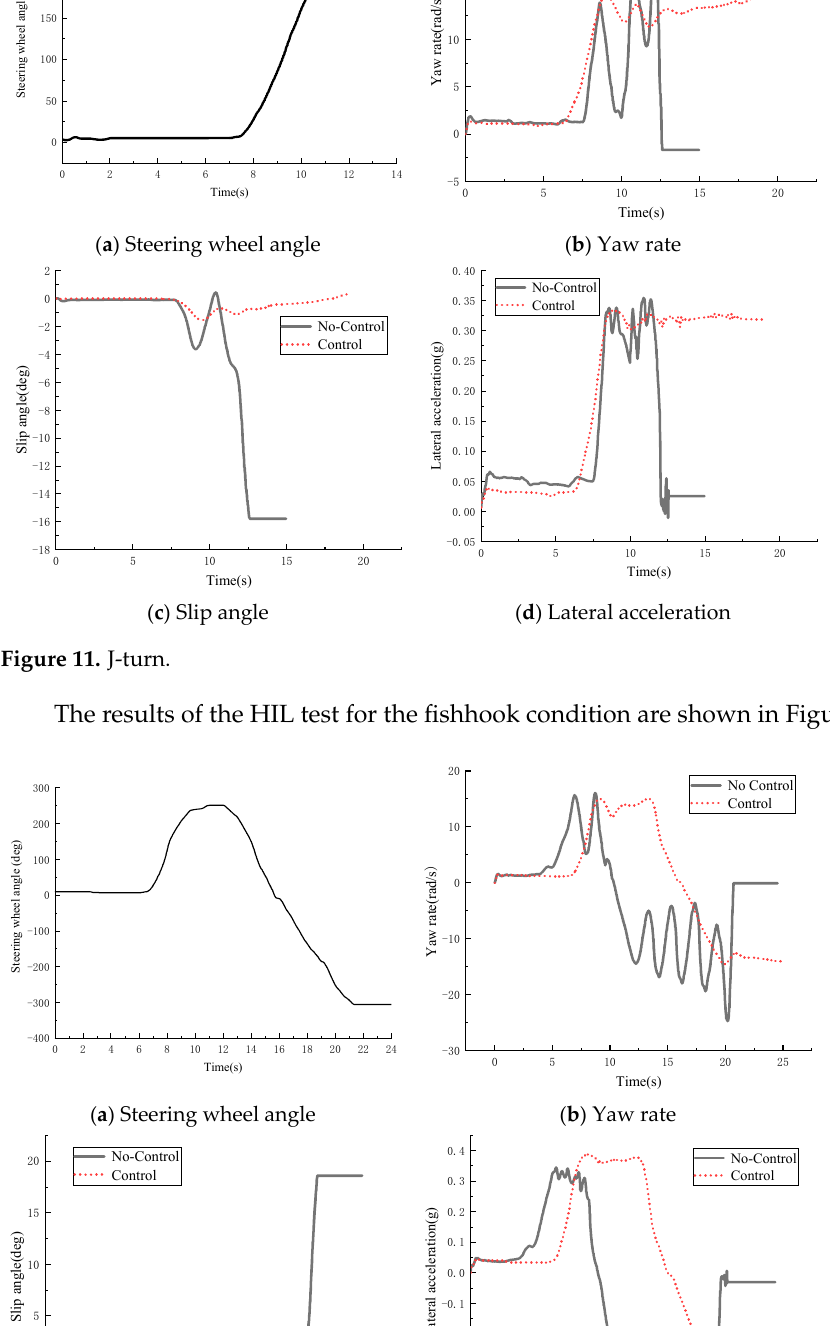
Figure 10. HIL flowchart.